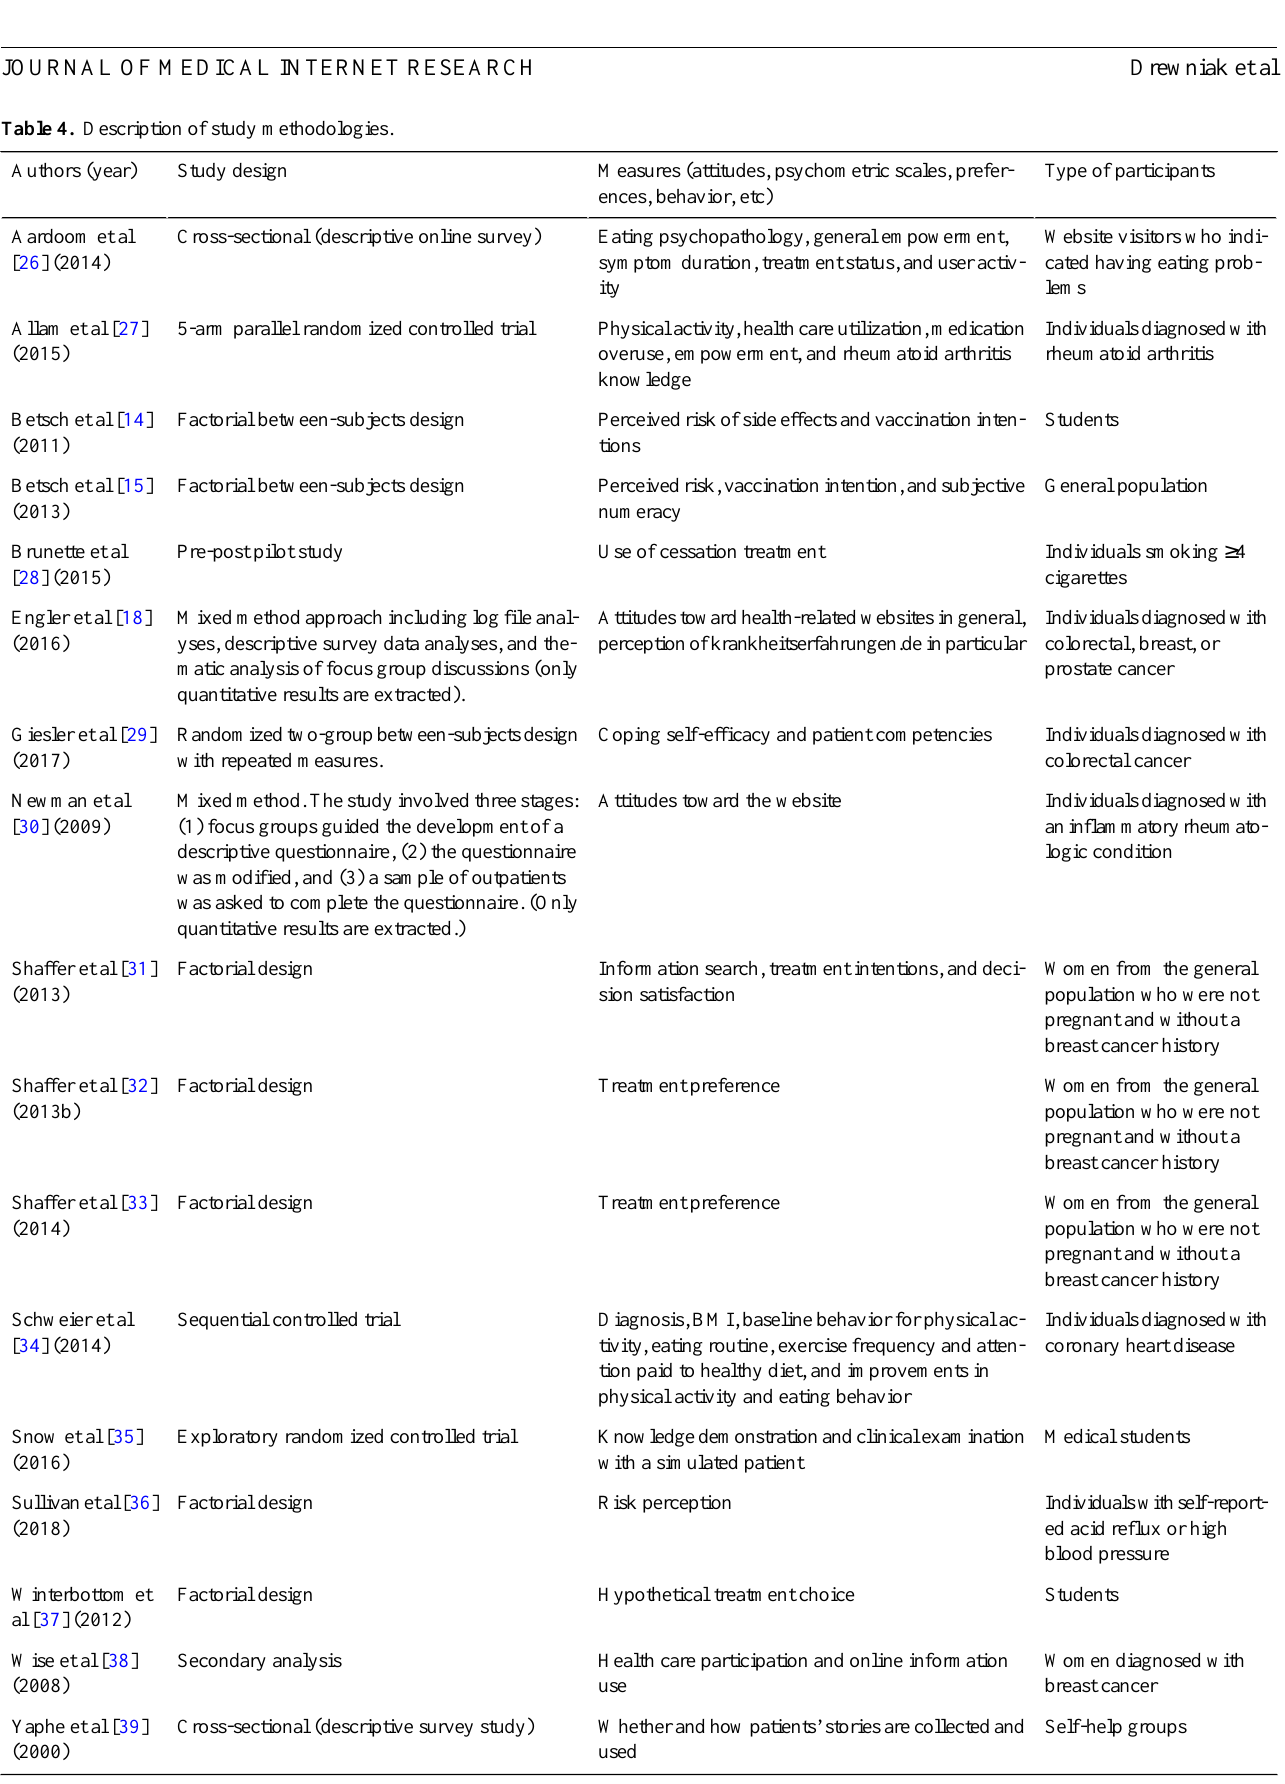
Table 4. Description of study